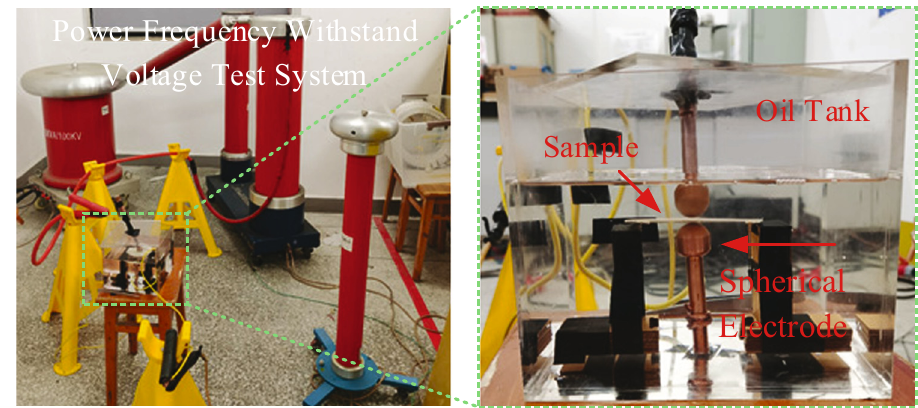
Figure 4: Power frequency withstand voltage test